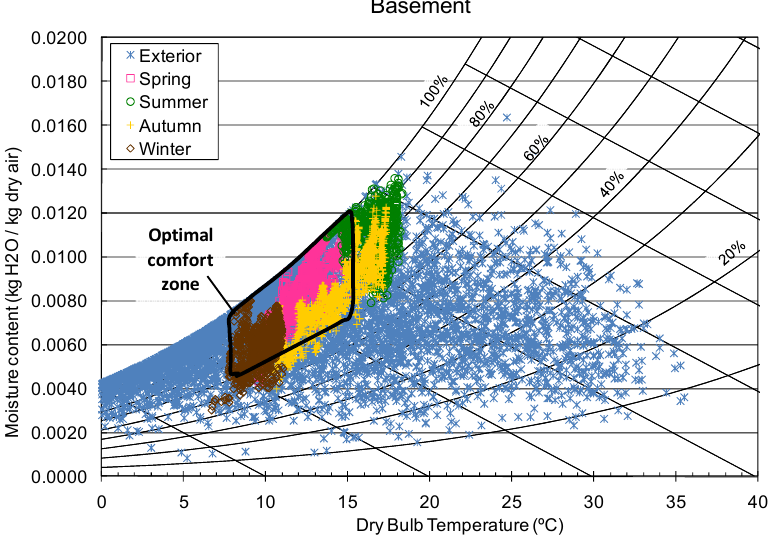
Figure 6. Indoor and outdoor hygrothermal conditions of the basement construction. Four daily values represented (00:00, 6:00, 12:00 and 18:00) over the 2006–2009